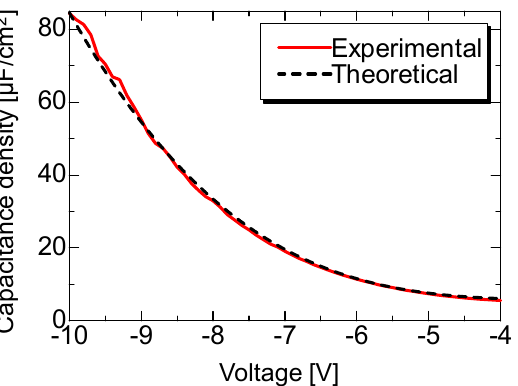
Figure 5. C - V characteristics of the SiNW MOS capacitor using ATA ( L = 8 μ m) in the high voltage region ( − 10 V < V < − 4 V). The solid line shows an experimental curve, and the dashed line shows theoretical capacitance density represented by (10).